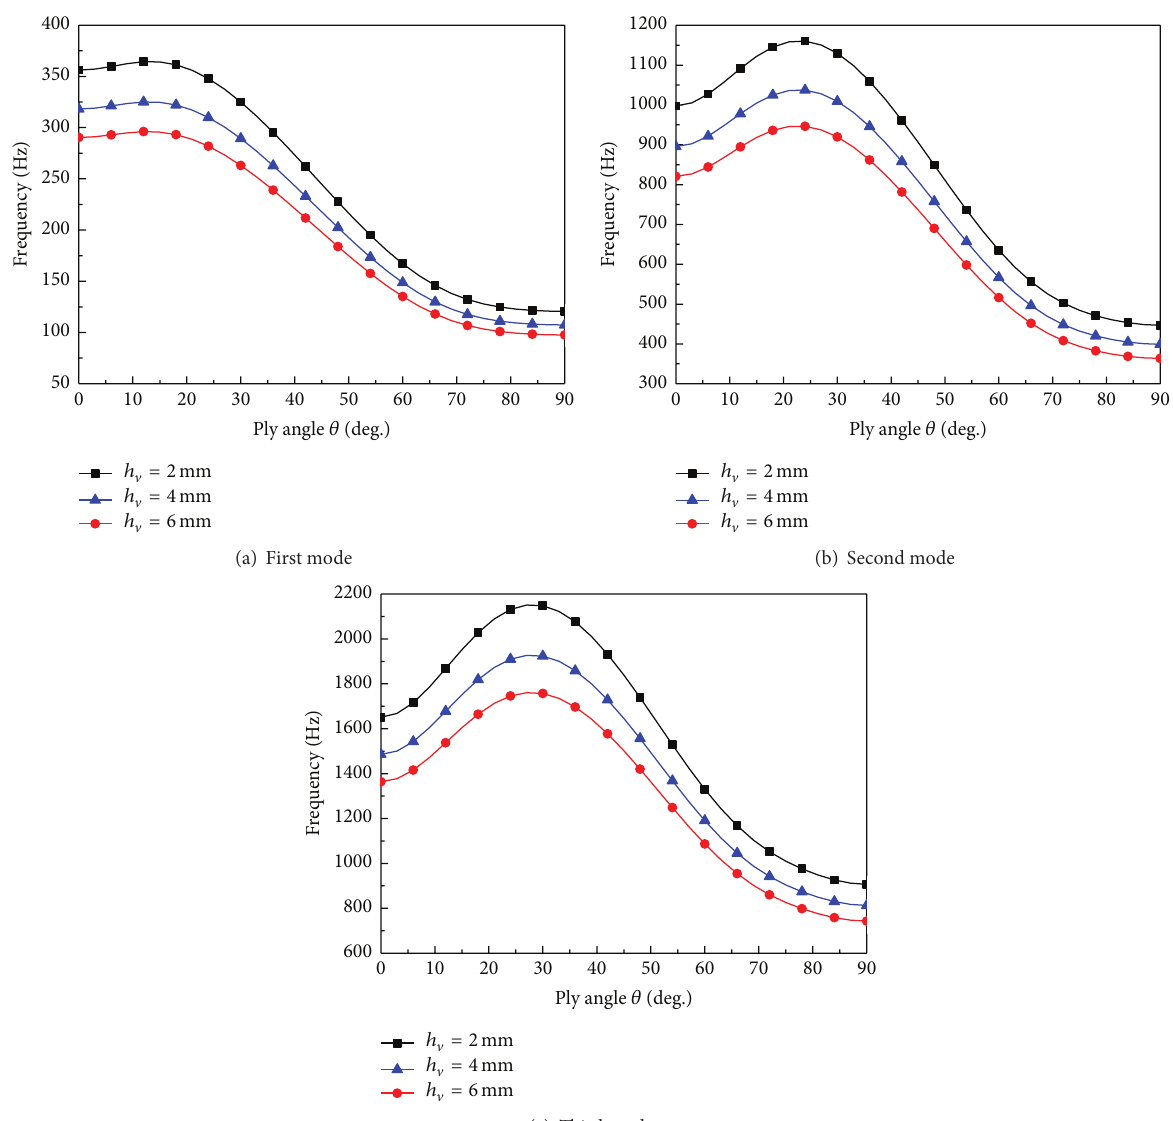
Figure 4: The first three natural frequencies versus fiber angle for various thicknesses of viscoelastic damping layer ( ℎ 𝑐 = 2 mm, Ω = 0).